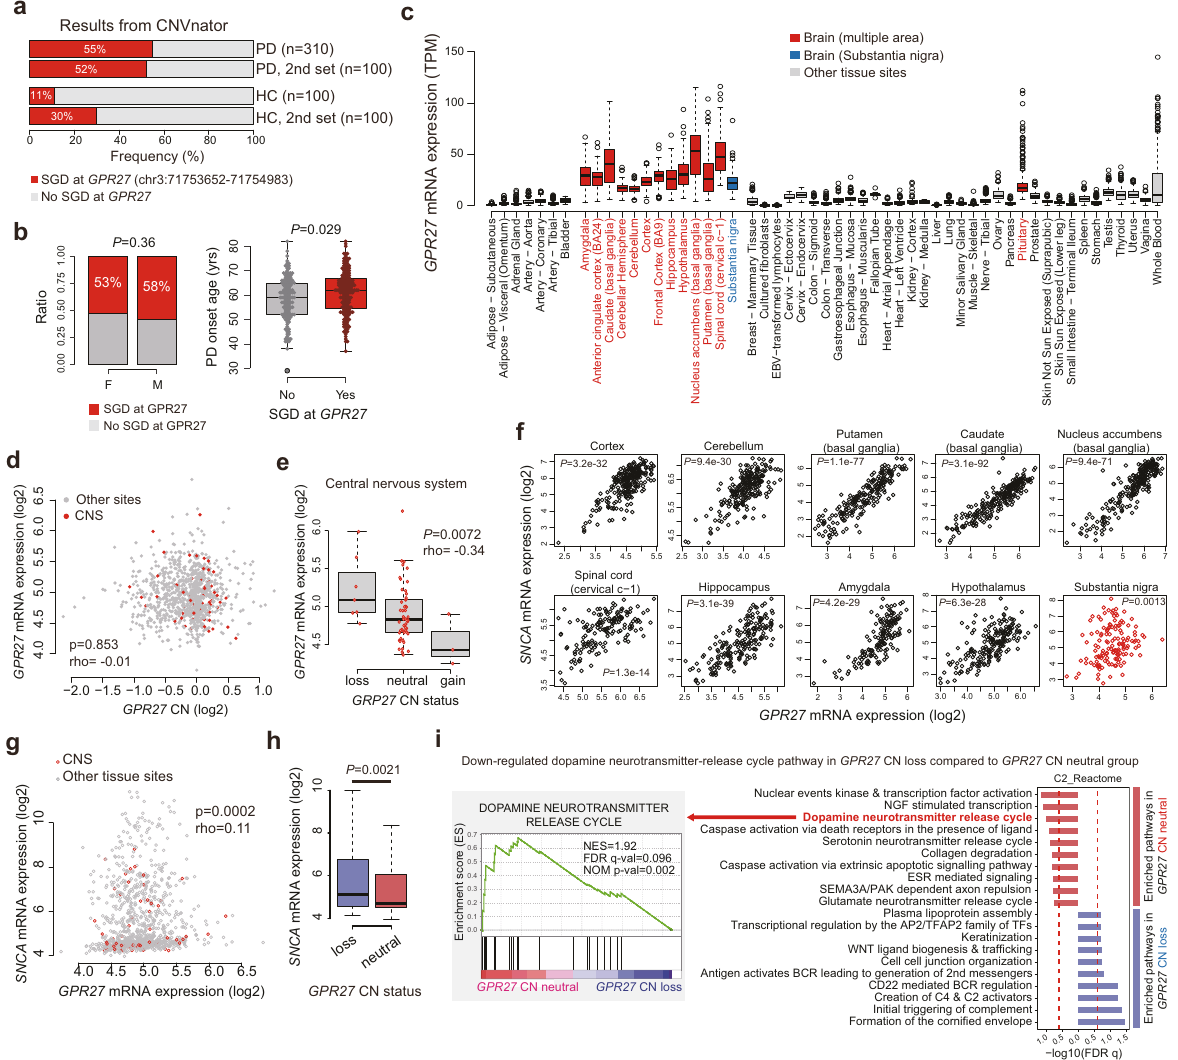
Fig. 6 Pathogenesis of GPR27 CN loss in PD. a Frequencies of SGDs in GPR27 between PD patients and healthy controls. b Associations between patient sex and age of onset of PD based on SGDs in the primary cohort (Fisher ’ s exact test and Wilcoxon-rank sum test, respectively). c GPR27 showed signi fi cant brain tissue-speci fi c expression patterns, including those in the substantia nigra (data obtained from the GTEx project). d No correlation between GPR27 CN loss and GPR27 mRNA expression. Analysis (Spearman correlation test) based on data from CCLE. e Negative correlation between GPR27 mRNA expression and GPR27 CN status in the CNS. Analysis (Spearman correlation test) based on data from CCLE. f , g Signi fi cant correlations between SNCA and GPR27 mRNA expression in brain tissues, including those in the substantia nigra (GTEx database) ( f ) and in cancer cell lines (CCLE data) ( g ) (Spearman correlation test). h Higher SNCA mRNA expression associated with GPR27 CN loss. Analysis (Wilcoxon-rank sum test) based on data from CCLE. i Differences in the dopaminergic pathway between GPR27 CN loss and GPR27 CN neutral samples, indicating a downregulated dopaminergic pathway in the GPR27 CN loss group. Gene set enrichment analysis was based on CCLE data. CCLE Cancer Cell Line Encyclopedia, CN copy number, CNS central nervous system, SGD small genomic deletion, PD Parkinson ’ s neurotransmitter release cycle. Transcriptional or posttranscriptional found to be associated with a decreased risk of PD development. upregulation of SNCA has been suggested to cause PD 48 . Although We hypothesized that these different contributions to PD risk are the causal relationship between GPR27 CN loss and upregulated related to advantages and disadvantages in the evolutionary SNCA expression is unclear, we speculate that the GPR27 loss development of the human brain. Among the deletions, we precedes alteration of SNCA expression, considering their role in detected clustered small genomic deletions located in the GPR27 signal transduction. Reduced dopamine neurotransmitter levels in region of PD patients. GPR27 is a G protein-coupled receptor PD contribute to the manifestation of motor and nonmotor involved in neuronal plasticity and energy metabolism and is symptoms of PD, though it had been suggested as the consequence expressed in the brain 47 . In particular, the small deleted regions of alpha-synuclein deposition and dopaminergic neuronal loss. are enhancers located in the TAD, suggesting that their alterations Whether GPR27 CN loss contributes to symptom development in may affect protein production, unlike other SNVs in noncoding addition to neuronal death needs further investigation. regions. Furthermore, several PD-associated candidate SNVs were We also con fi rmed GPR27 CN loss to be associated with identi fi ed, speci fi cally intronic SNVs located within TCF7L2 upregulated SNCA expression and a downregulated dopamine